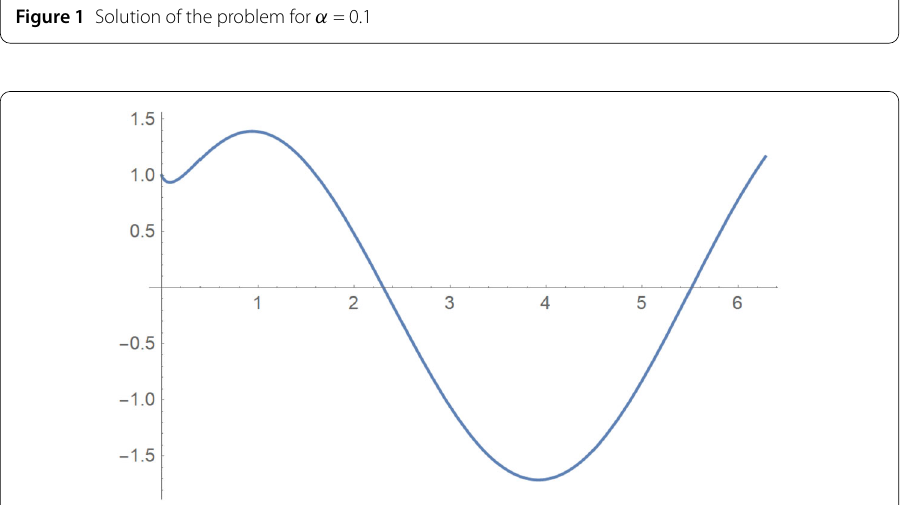
Figure 2 Solution of the problem for α =